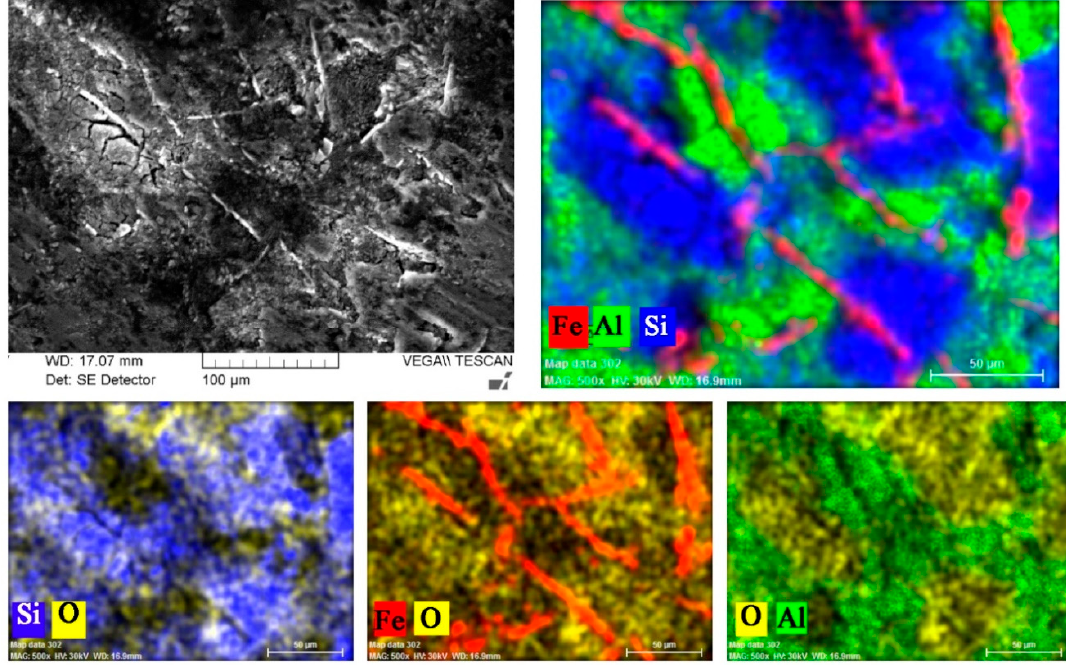
Figure 6. Energy dispersive X-rays (EDX) analysis of corrosion localization of alloy B after testing.